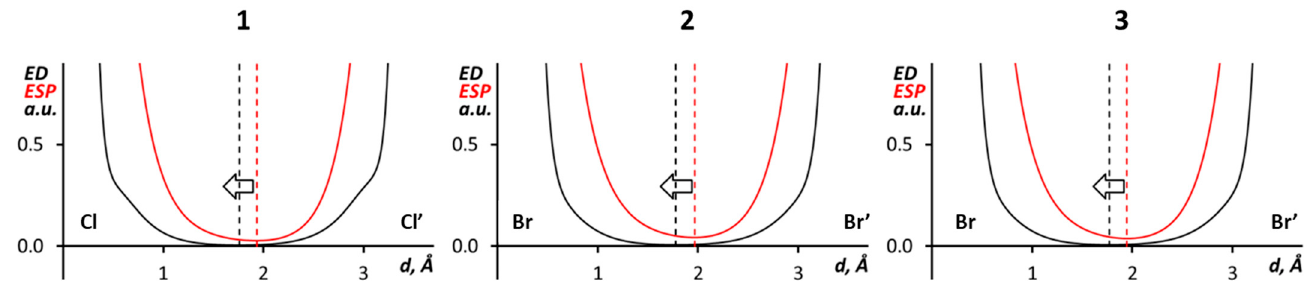
Figure 5. The ED and ESP 1D profiles along the X ∙∙∙ X’ bond paths for the ( 1 ) 2 (left), ( 2 ) 2 (middle), and ( 3 ) 2 (right) dimeric clusters of type I.